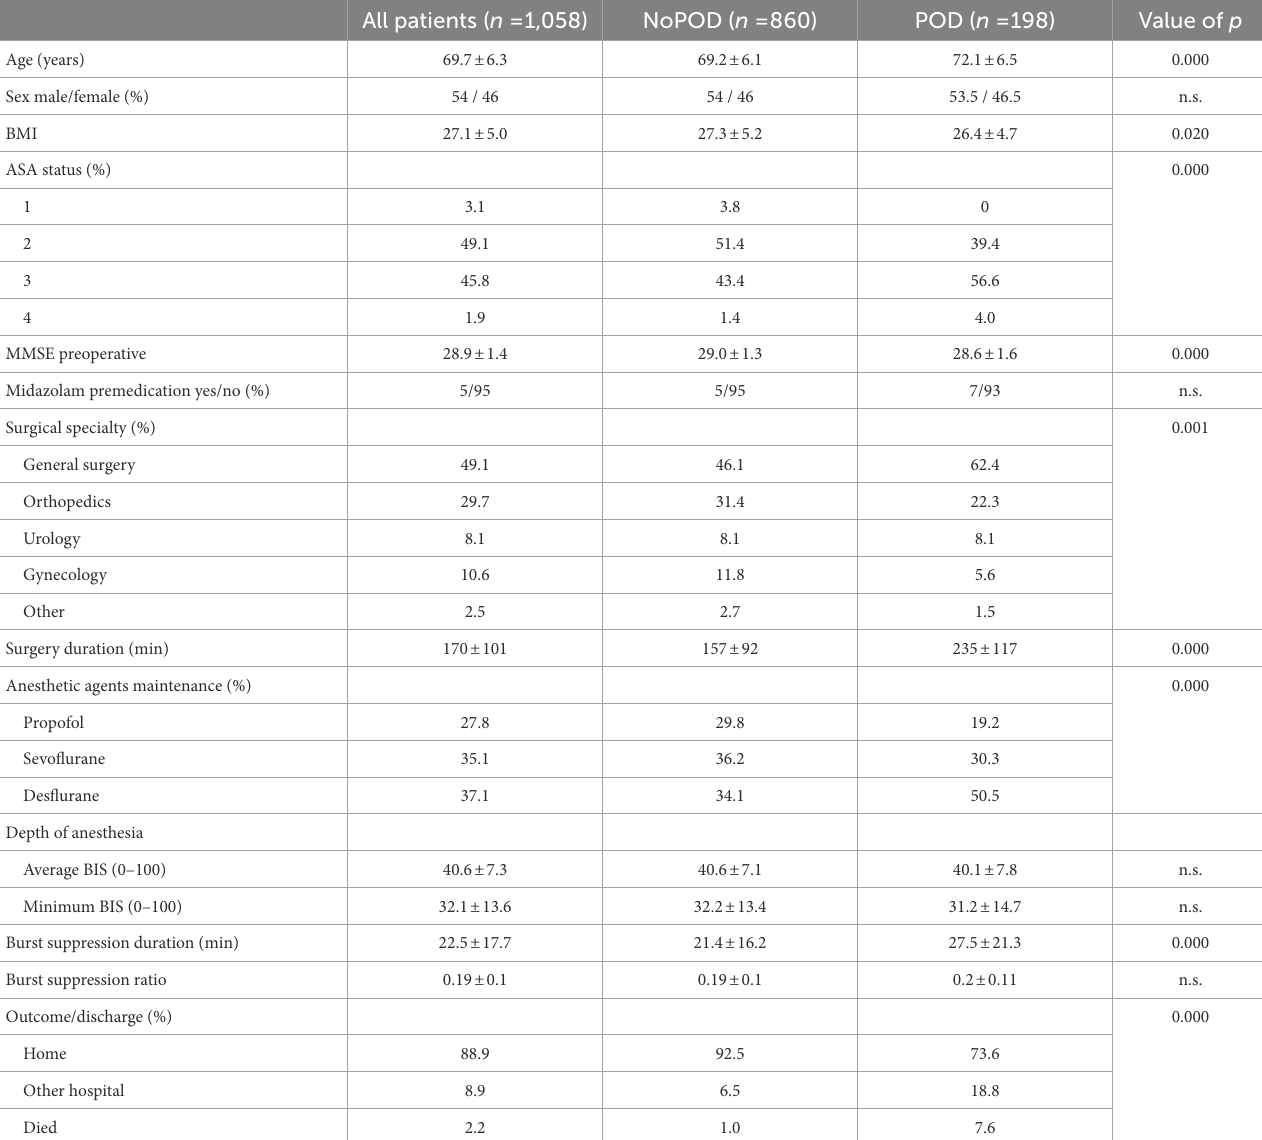
TABLE 1 Patients characteristics for patients with postoperative delirium (POD) and without